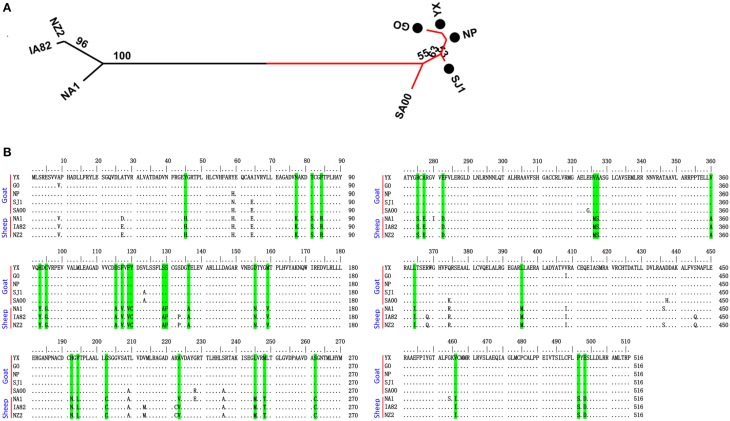
Phylogenetic analysis and multiple alignment of deduced amino acid sequence of ORFV008. (A) The phylogenetic relationship was constructed by the maximum-likelihood method using MEGA 5.0 software. Numbers at the branching points indicate the bootstrap support calculated for 1000 replicates. Black cycles: four Fujian goat ORFVs. (B) Green marks are unique amino acid residues in goat genomes.